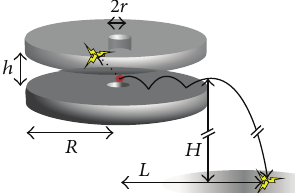
Figure 6: Scheme of the proposed device to reduce the vertical velocity spread of the falling wave packet (see